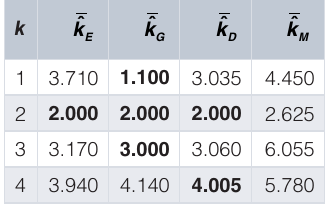
Table 4. Average cluster numbers over n = 200 runs.